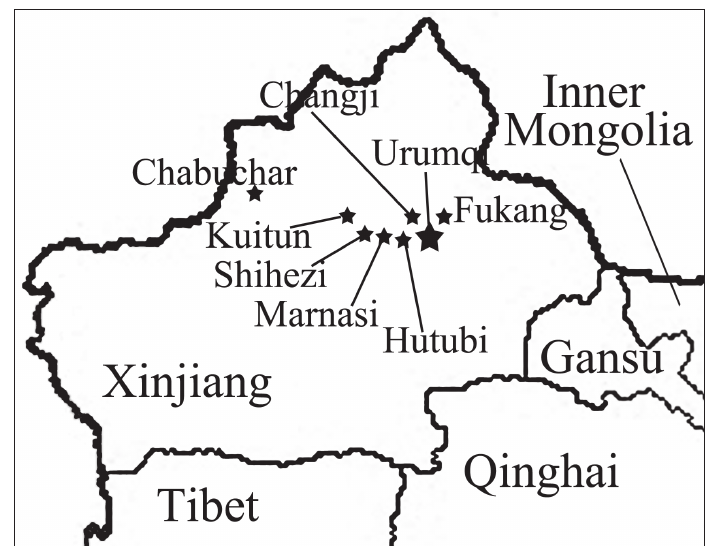
Figure 6. Records of Zyginidia eremita in Xinjiang. The large star denotes the type locality of Anagrus dmitrievi